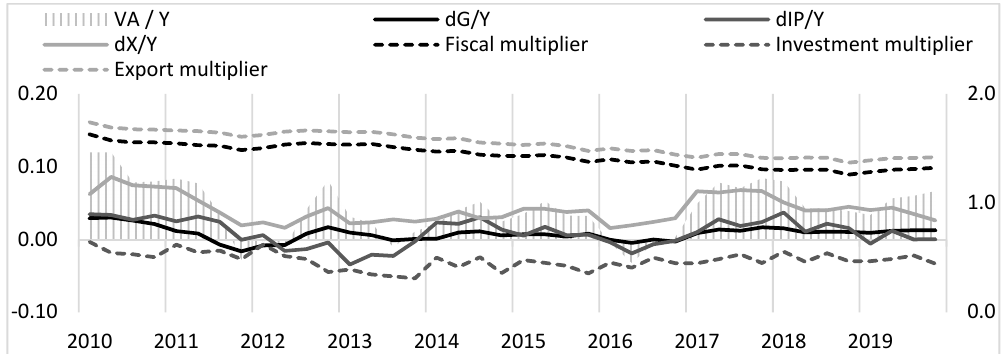
Figure 11. Growth rate of gross value added (main variables)—Germany, own work, source: Eurostat.